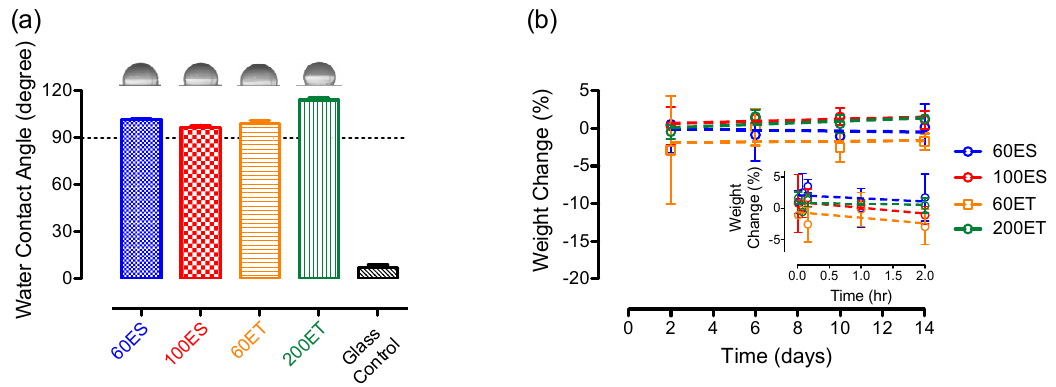
Figure 6. ( a ) Water contact angle study on the various PU films comparing to a glass control. ( b ) Water absorption and / or degradation study on various PU films over 14 days. Figure inset shows short-term study up to 2 h.